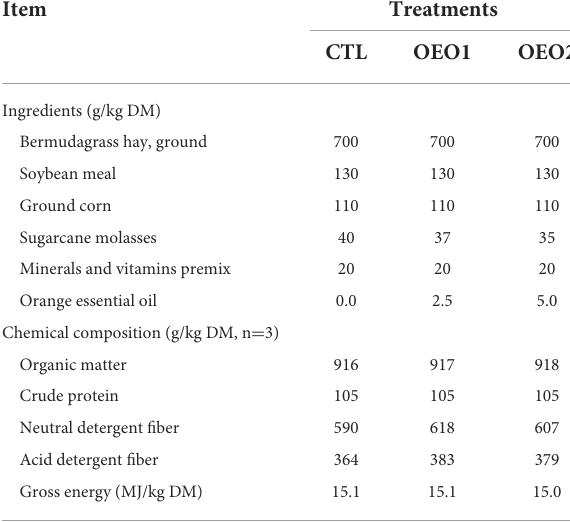
TABLE 1 Ingredient and nutrient composition of the total mixed